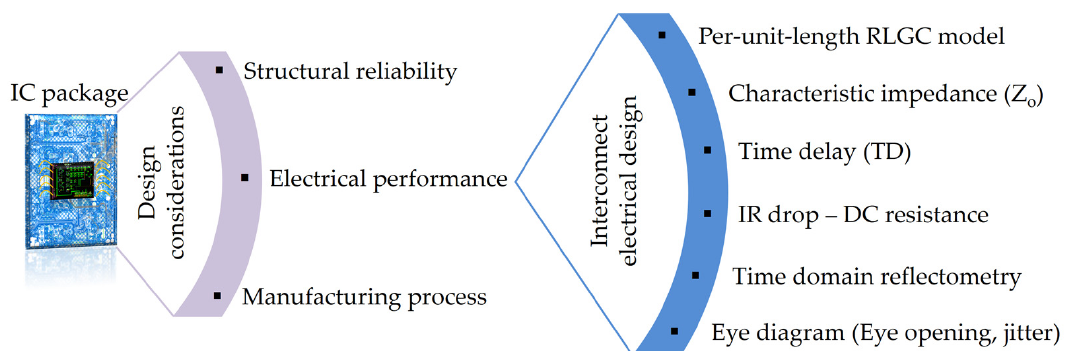
Figure 1. Design considerations and specifications for the electrical design of the integrated circuit (IC)-package interconnect.